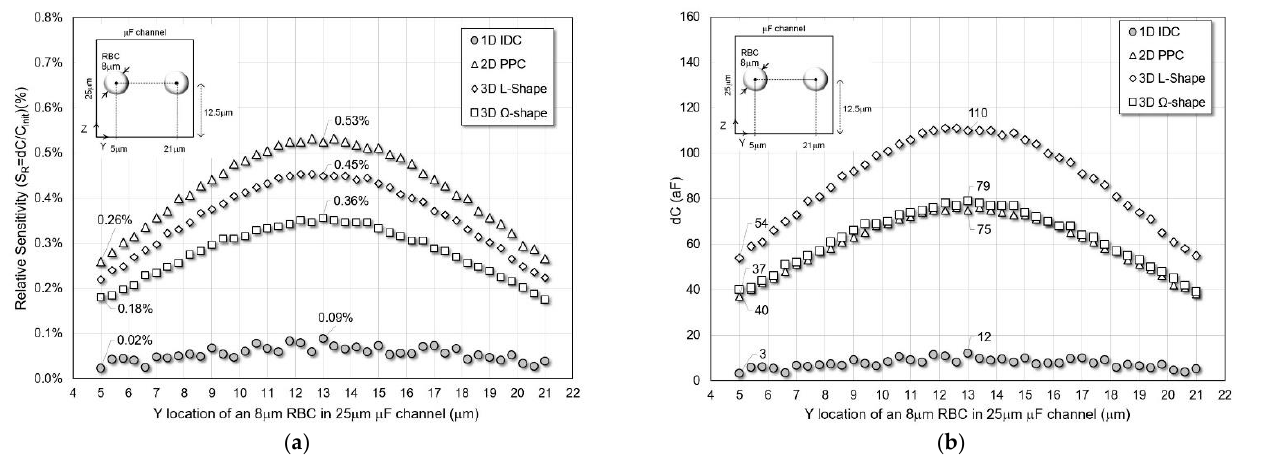
Figure 6. ( a ) Relative sensitivity and ( b ) capacitance change of the sensors for varying Y-location of an 8 μ m RBC cell in a 25 μ m microfluidic channel.